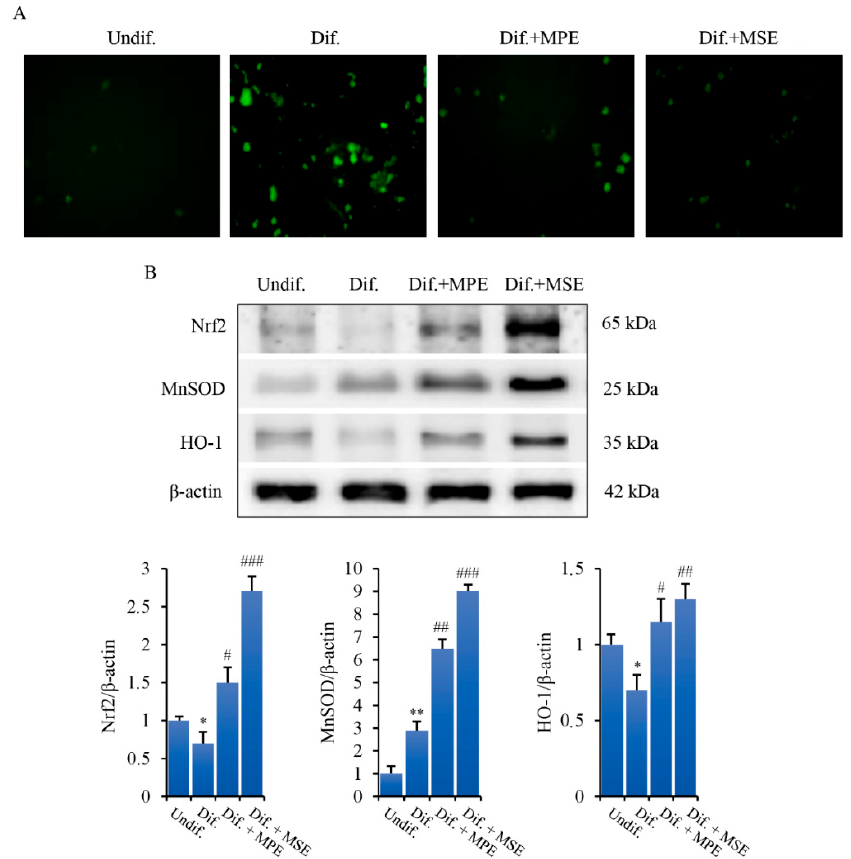
Figure 7. MPE and MSE exert anti-oxidant effects in 3T3-L1 adipocytes. 3T3-L1 cells were treated with pro-differentiative agents for 8 days in the presence or absence of 100 µ g/mL MPE or MSE, as reported in Methods. ( A ) Intracellular ROS were detected using the redox-sensitive fluorochrome H 2 -DCFDA. After differentiation, the medium was replaced with 10 µ M H2DCFDA solution and the incubation was protracted for 30 min at 37 ◦ C. The oxidation of the fluorochrome generates green fluorescence, which was visualized by a Leica microscope equipped with a DC300F camera using a FITC filter. Representative micrographs of fluorescence microscopy were taken at 200 × magnification. ( B ). Western blotting analysis of Nrf2, MnSOD and HO-1 in 3T3-L1 cells differentiated without or with 100 µ g/mL MPE or MSE. Equal loading of proteins was verified by immunoblotting for β -actin and showed values were assigned in relation to undifferentiated cells (Undif.). The bar graphs represent the mean of three independent experiments ± SD. * p < 0.05, ** p < 0.01 with respect to the undifferentiated 3T3-L1 cells, # p < 0.05, ## p < 0.01 and ### p < 0.001 with respect to the differentiated untreated 3T3-L1 cells (Dif.).